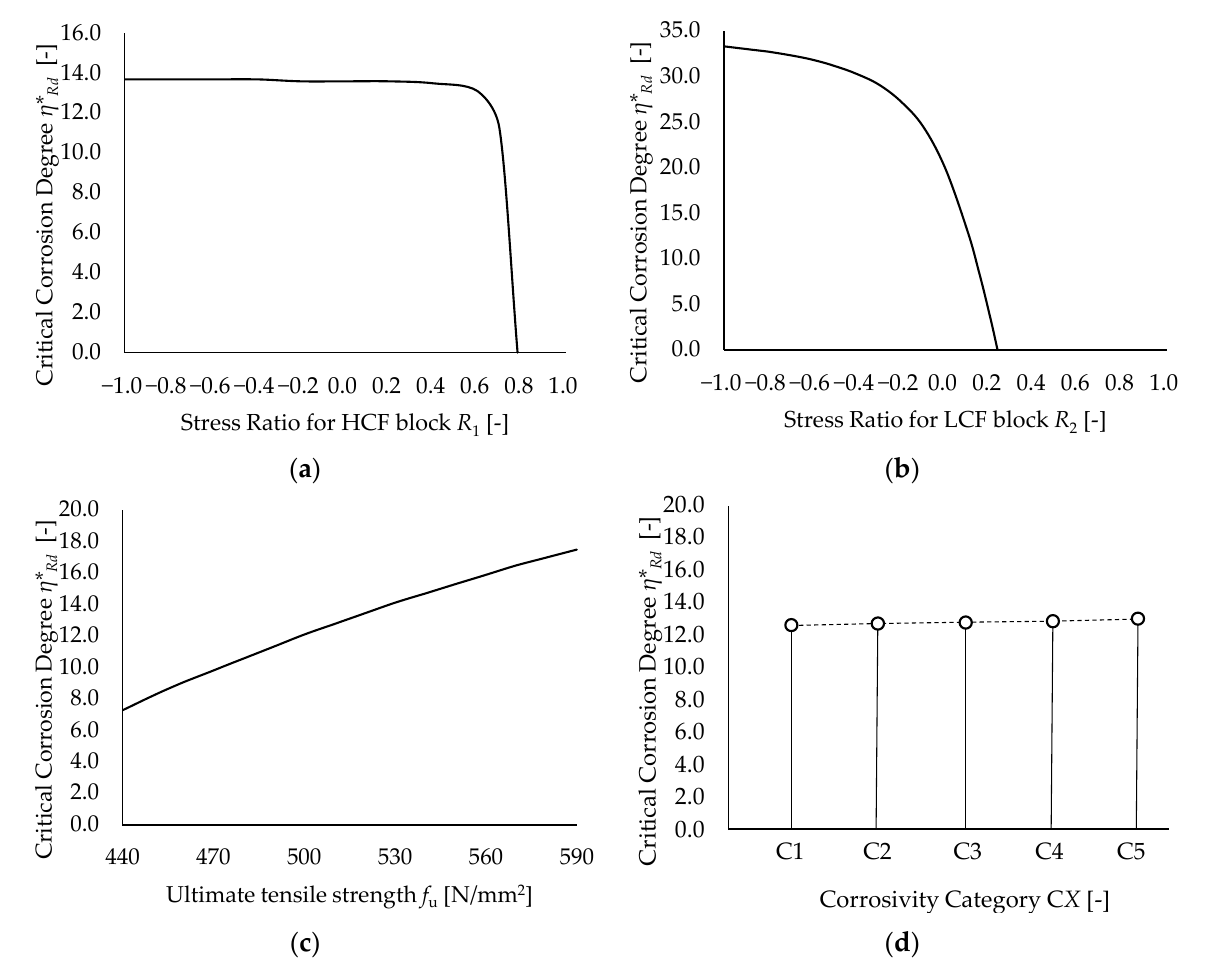
Figure 11. Results of parametrical analyses based on specimen S4 in terms of estimated η * Rd : ( a ) influence of stress ratio of the HCF block R 1 , ( b ) influence of stress ratio of the LCF block R 2 , ( c ) influence of AH32 tensile strength f u , and ( d ) influence of corrosivity category C X . Conversely, LCF block stress ratio R 2 has a significant influence on the predicted values of η * Rd (see Figure 11b) Namely, in the case of reversed corrosion LCF (i.e., for R 2 = − 1), the resulting critical corrosion degree (33.3%) is ≈ 2.5 times higher with respect to the reference value ( η * Rd = 13.1% for R 2 = 0.1). On the other hand, the critical corrosion degree rapidly drops to zero for R 2 = 0.26. This clearly highlights how the fatigue performance of specimen S4 is governed by the simultaneous effect of corrosion, local plasticization, and tensile mean